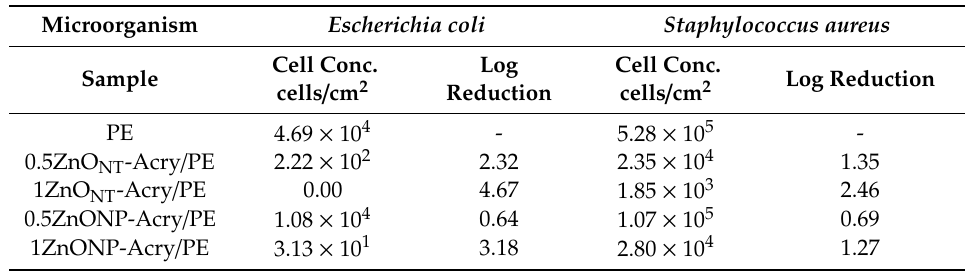
Table 1. Antibacterial results of coated PE containing ZnO NT and ZnONP at 0.5 and 1 wt. % against di ff erent